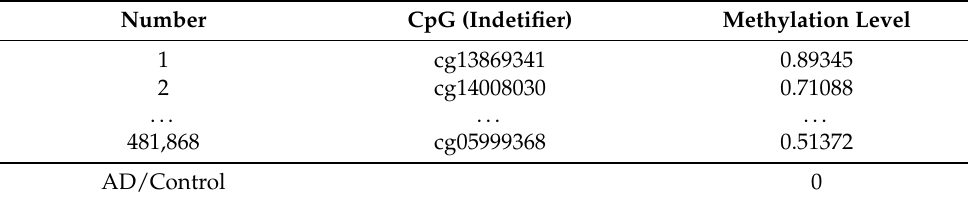
Table 2. Single patient methylation data.